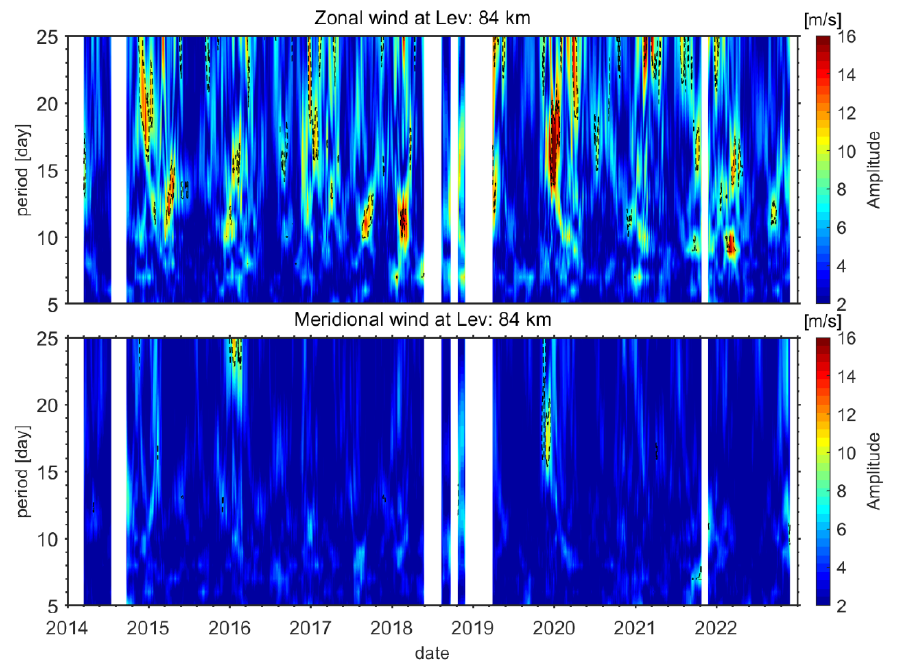
Figure 3. Lomb Scargle Spectral of 84 km zonal ( upper panel ) and meridional ( lower panel ) wind observed by the meteor radar between April 2014 and December 2022. The area surrounded by the dashed lines indicates significant power according to the false alarm probability.